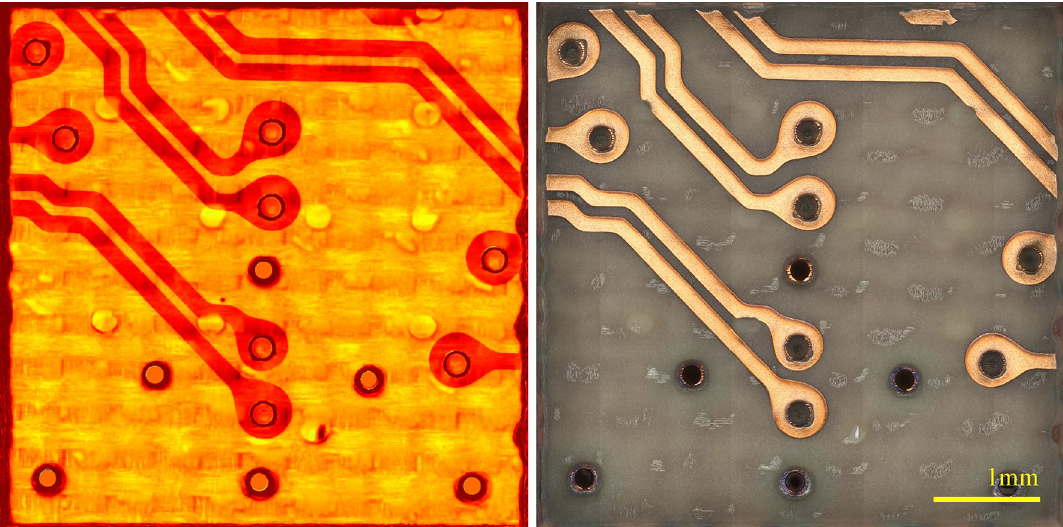
Figure 15. Automated image segmentation using the ablation rate information. Left: A heat map of the ablation rate (red is low, and yellow is high). Right: The optical image of the same